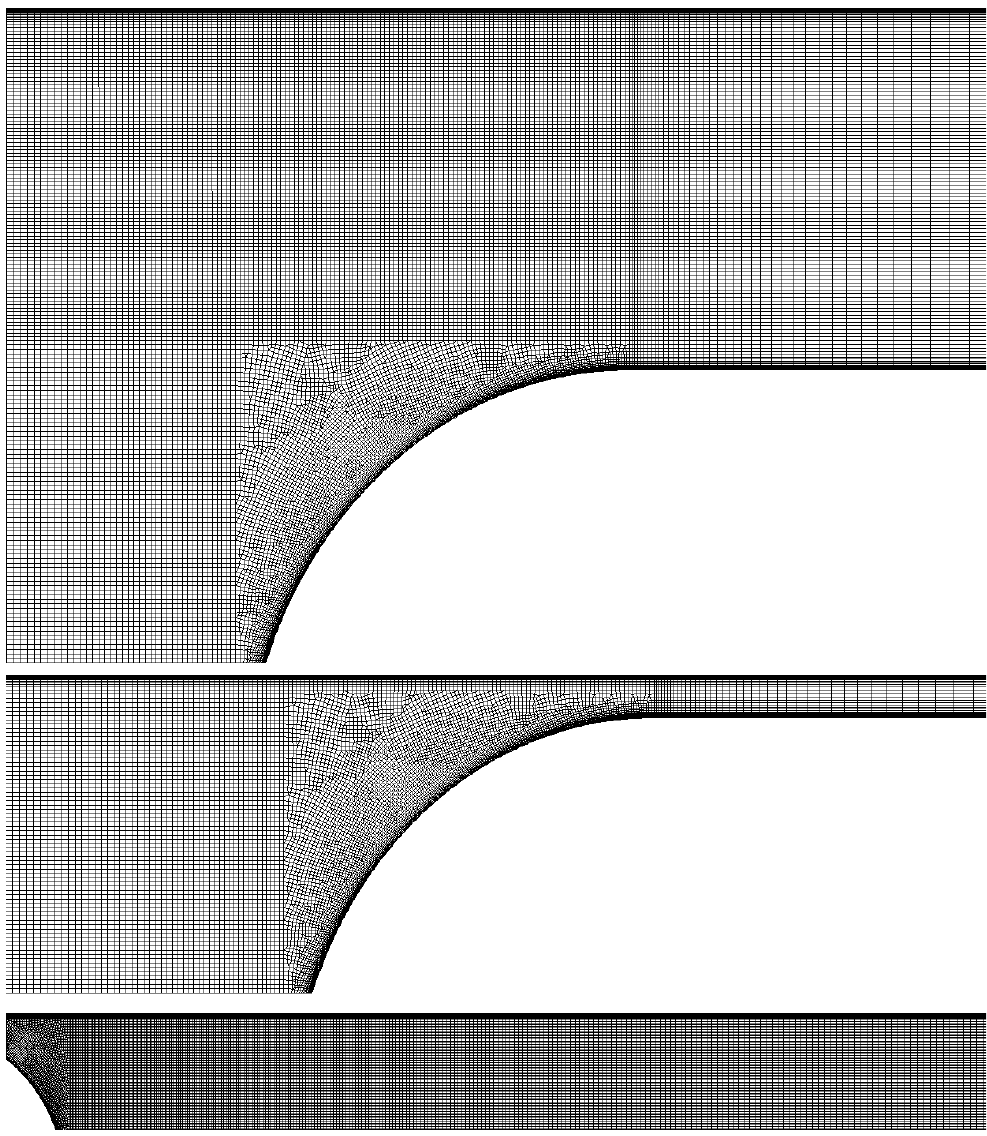
Figure 5. Captures for the mesh used in the base case. Except the upper one, which is for β = 0.2, the rest of the images are for β = 0.75. The top figures show the upstream domain, and the bottom one shows the